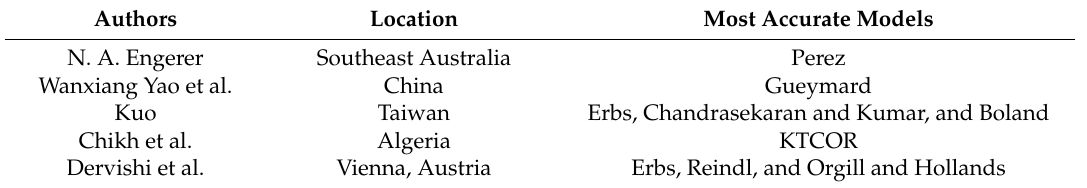
Table 3. Summary of studies on identifying the most accurate diffuse models for horizontal surfaces.